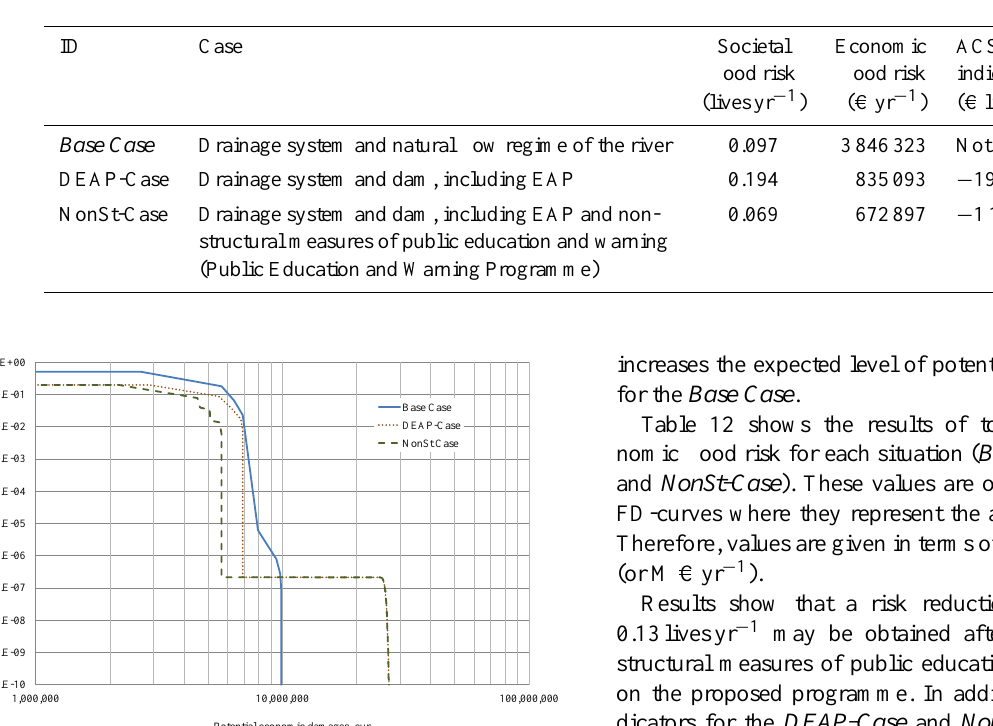
Table 12. Total flood risk for the case study.